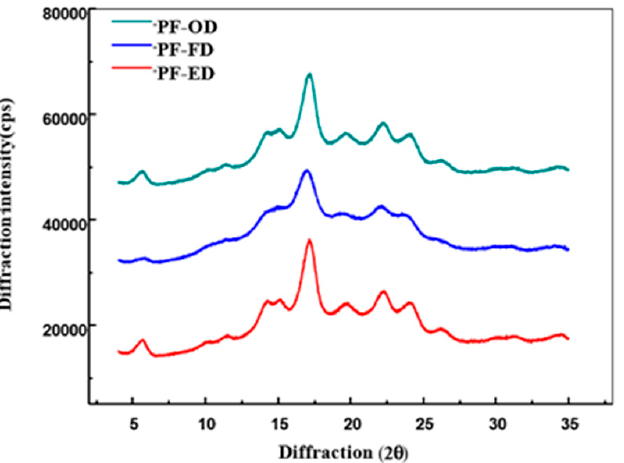
Figure 2. XRD patterns of potato flour samples subjected to different drying methods.PF-ED: potato flour dried for ethanol drying; PF-FD: potato flour dried for freeze drying; PF-OD: potato flour dried for oven drying.